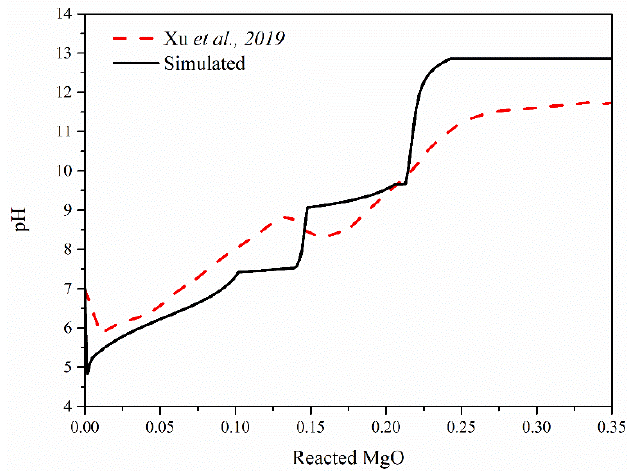
Figure 1. pH values of MP8H5 and experimental data in Ref. [15].